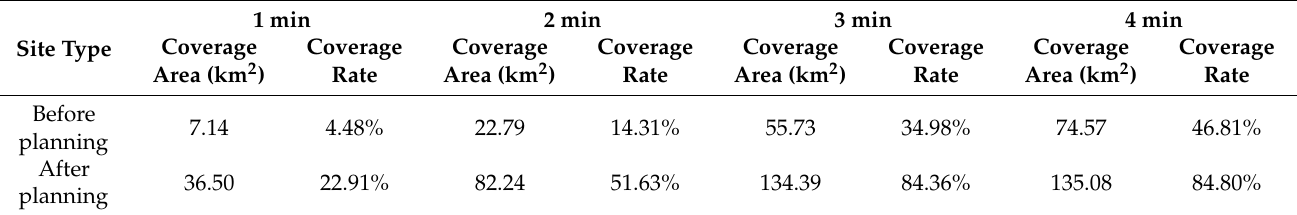
Table 6. Coverage area in different time periods before and after planning.